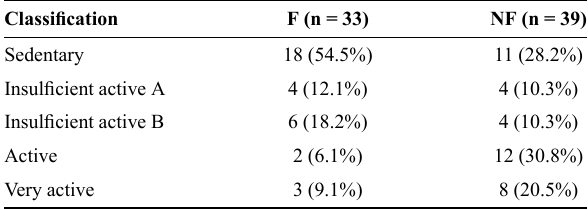
Table 4 - Levels of physical activity based on the